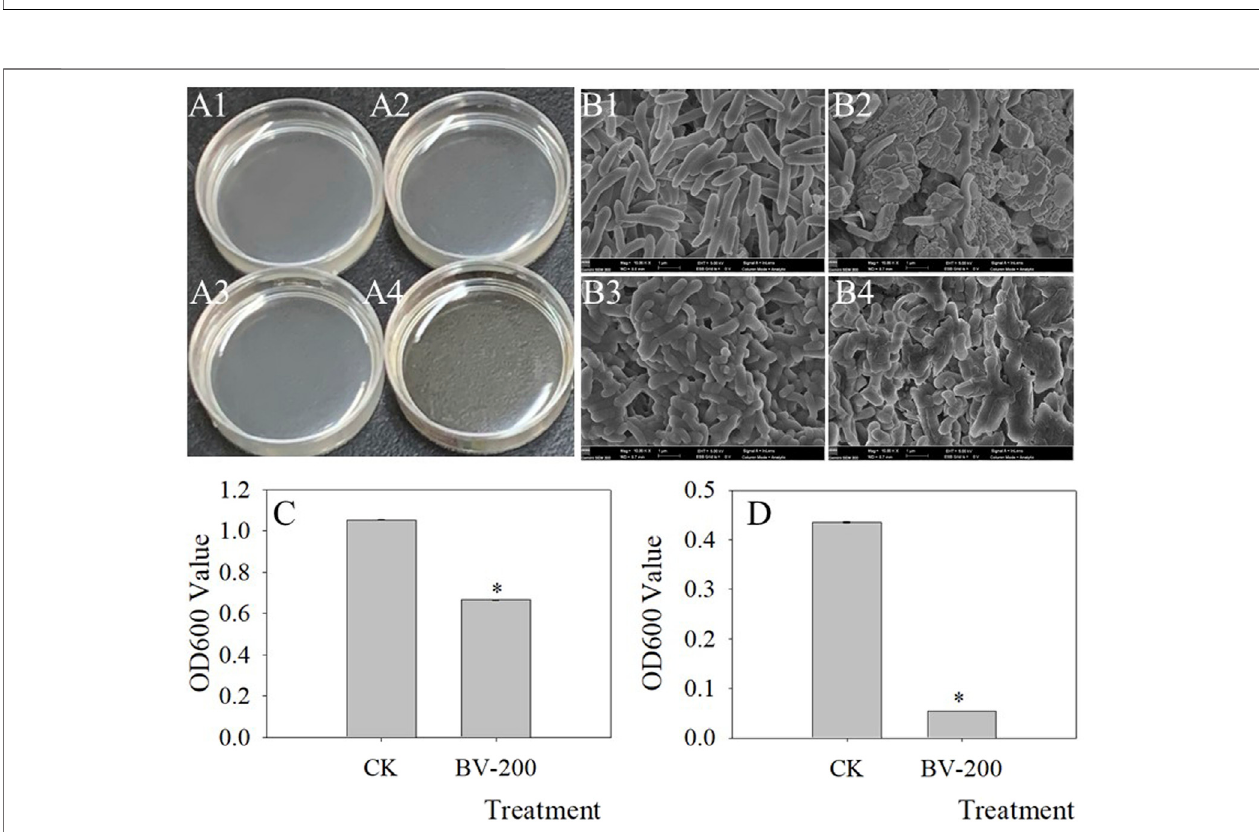
FIGURE8| AntimicrobialeffectofBVnanomaterials.Imagesofbacterial fl uid (A) ,SEM (B) ofbacteria,andOD600valueofbacterial fl uid (C,D) .A1,A3,B1,andB3 were the controls only with added bacteria. A2, A4, B2, and B4 were the treatments with added bacteria and 200 μ g ml − 1 BV. A1, A2, B1, and B2 were added to Fusariumoxysporum f.sp. vasinfectum. A3,A4,B3,andB4wereaddedto Thanatephoruscucumeris (Frank)Donk . BarofCandDwasstandarderror.Asterisksabove the bar of C and D indicate that there were signi fi cant differences between the treatments at p < 0.05. N (cid:2) 3.